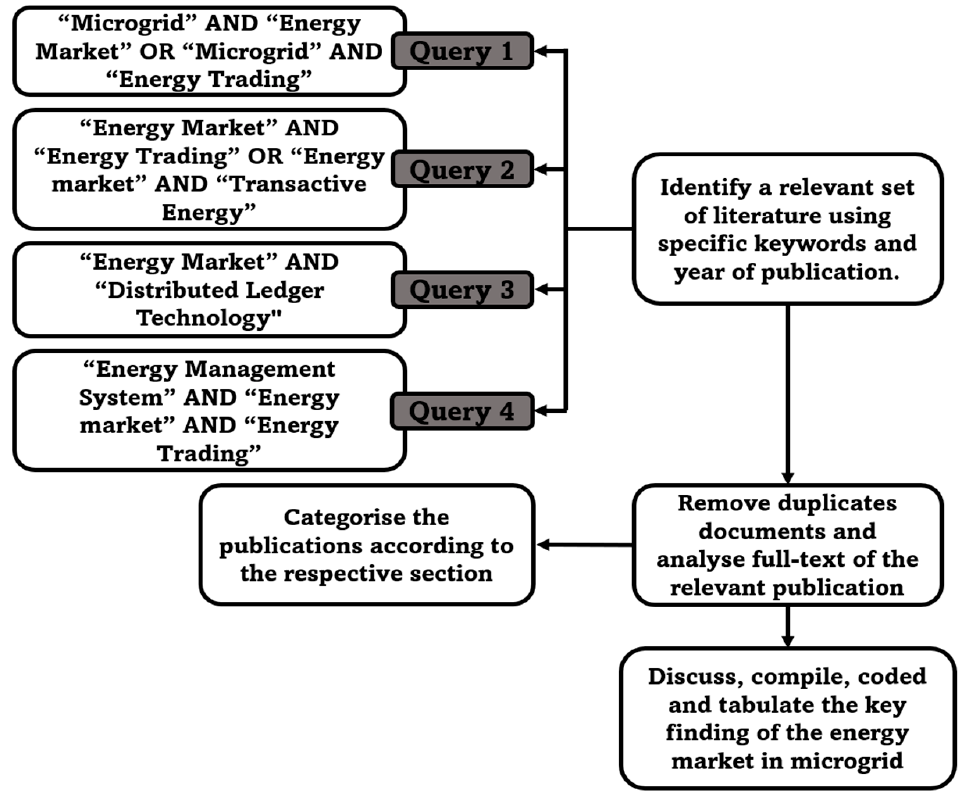
Figure 2. Flowchart of the systematic literature review.